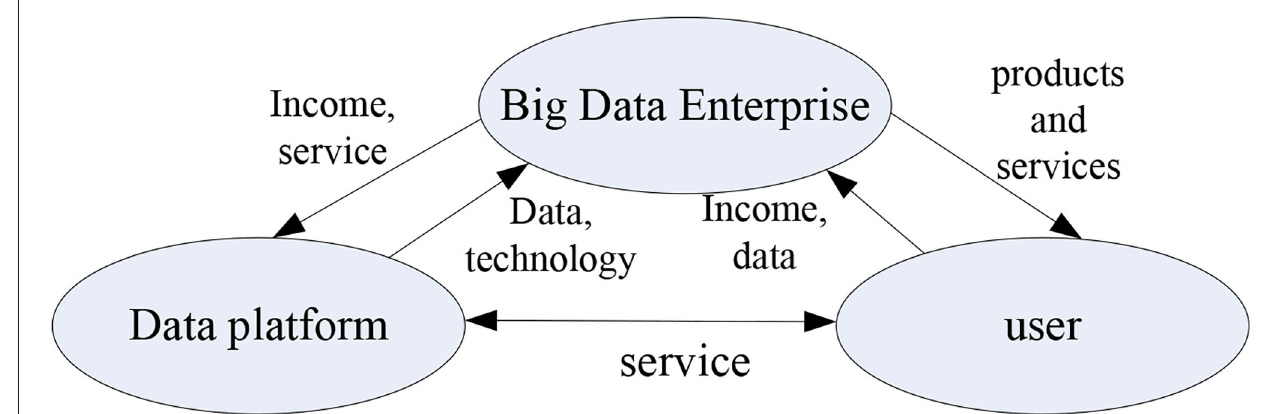
FIGURE 4 | The relationship between the three major elements of the ecosystem.